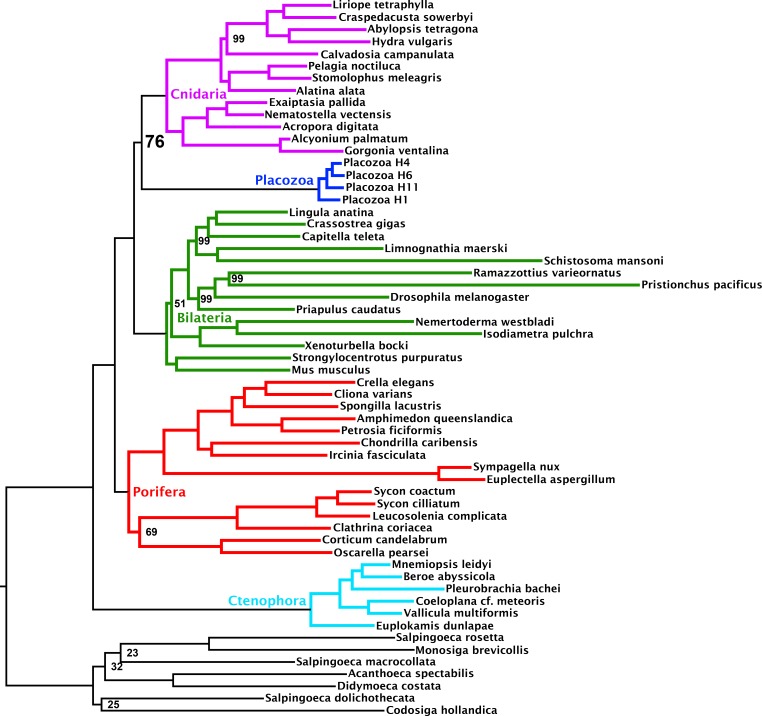
Maximum likelihood tree under the C60 +LG + FO + R4 profile mixture model, inferred from the 430-orthologue matrix with full taxon sampling.Nodes annotated with ultrafast bootstrap supports with NNI correction; unannotated nodes received full support.